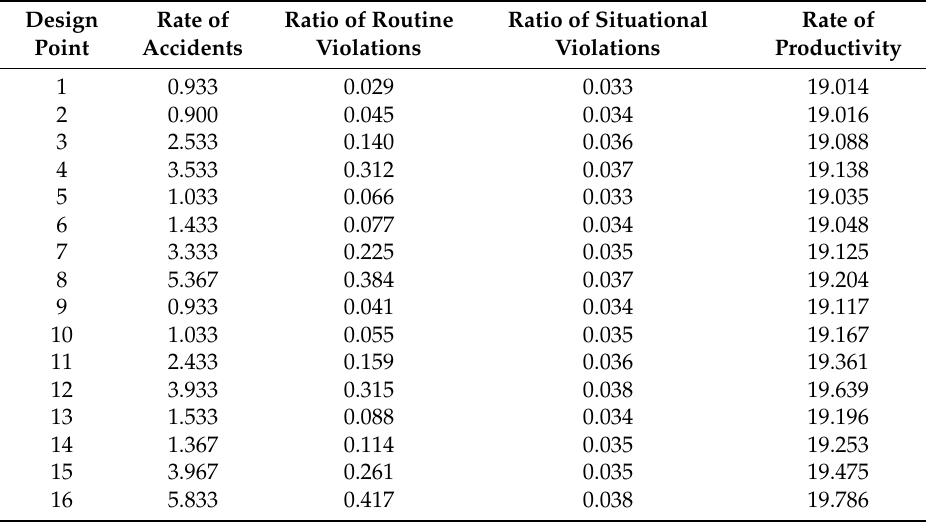
Table 7. Average values of response variables for the “high” hazard onsite